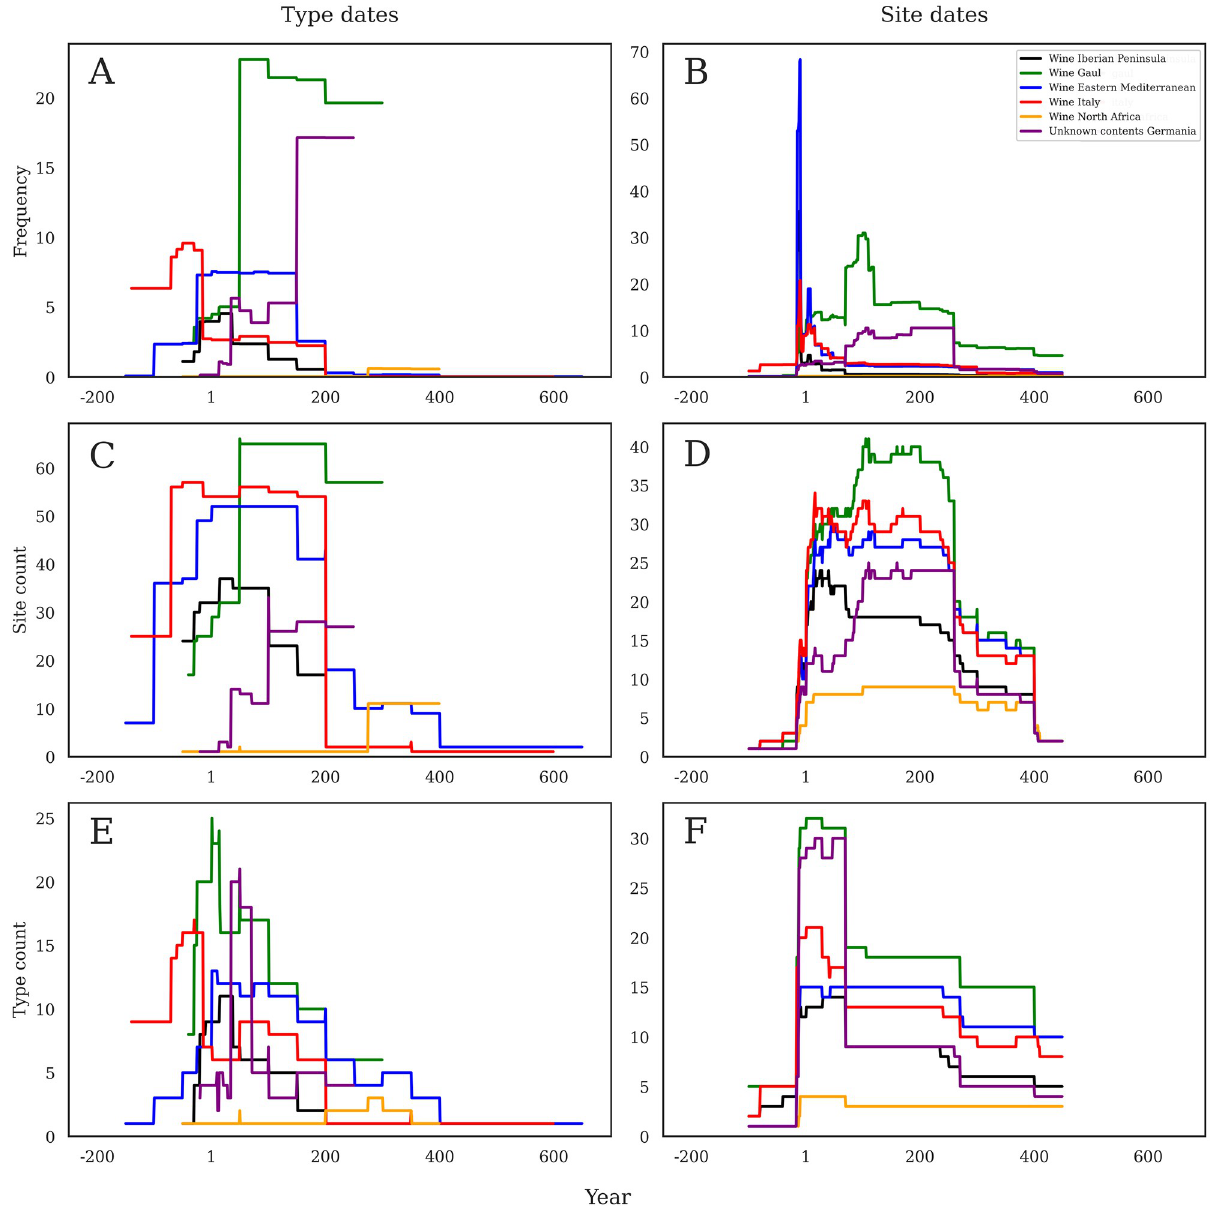
Fig 7. a-f. Wine consumption through time. Comparison of six main wine-producing regions across the three different methods of analysis according to production dates (left) and consumption dates (right). Note that Y axes are not constant.